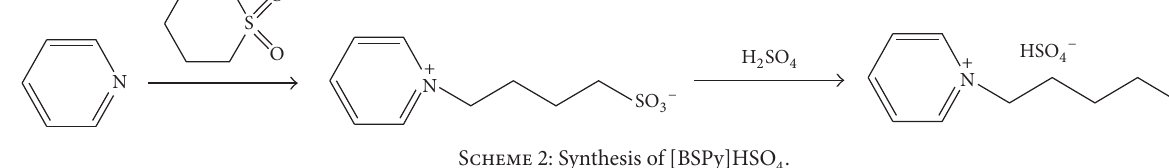
Scheme 2: Synthesis of [ BSPy ] HSO 4